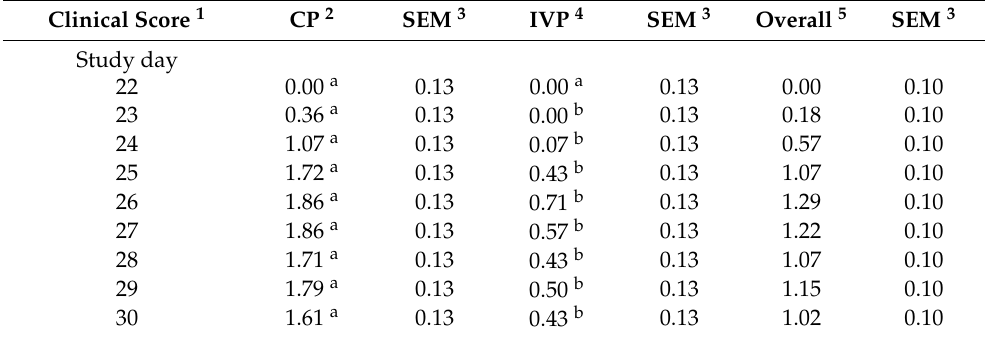
Table 4. Clinical scores of pigs with model adjusted means by treatment groups used to test core antigen bacterin with an immunostimulant on health and performance outcomes when challenged with enteric and respiratory